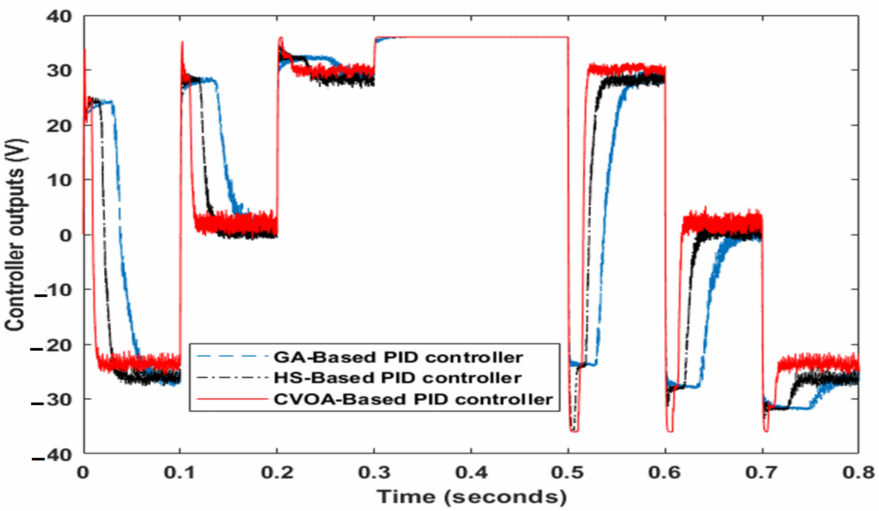
Figure 13. The controller outputs at several operating points of reference